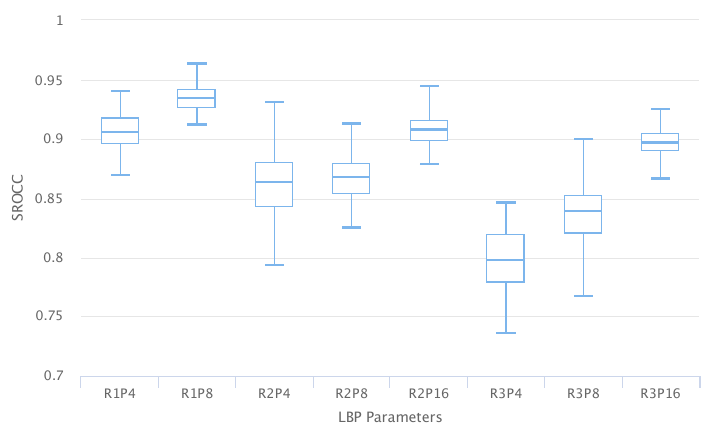
Figure 25. SROCC distribution on LIVE2 using basic